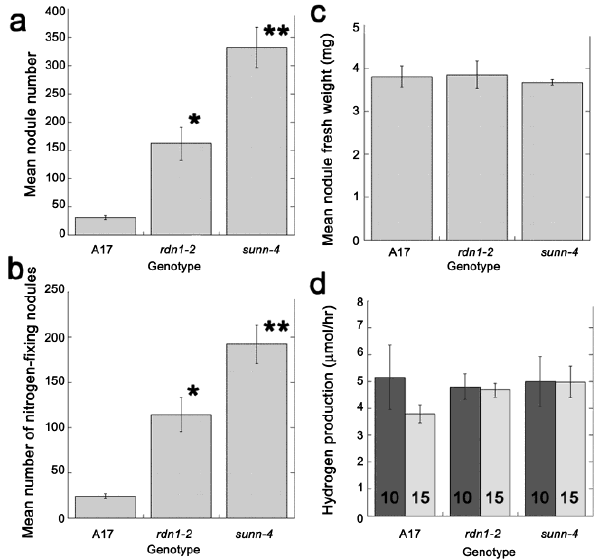
Figure 2. AON mutants and wild type plants fix equivalent amounts of nitrogen. Roots of A17, rdn1-2 and sunn-4 plants were evaluated 15 days after inoculation with S. medicae . Means ± SE are per genotype ( a ) Mean nodule number ( b ) Mean number of nitrogen fixing (pink) nodules ( c ) Mean nodule fresh weight (ten samples of three nodules each from five to six plants per genotype). ( d ) Hydrogen production (  mol/hr) as a proxy for nitrogen fixation rate (see Experimental Section). Measurements were taken on the same plants at both 10 and 15 days after inoculation with S. medicae in two biological replicates. A17 ( n = 9), rdn1-2 ( n = 10) and sunn-4 ( n = 9). Statistically significant differences from wild type based on Student’s t-test are indicated by * ( p < 0.05) and ** ( p <